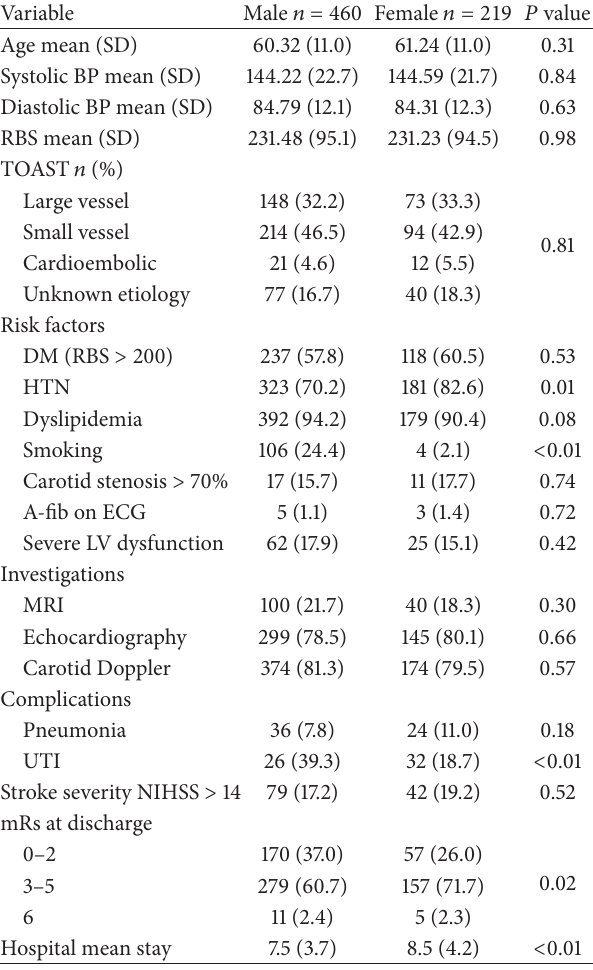
Table 3: Risk factors of stroke patient by gender. Table 4: Distribution of covariates among stroke patients with young